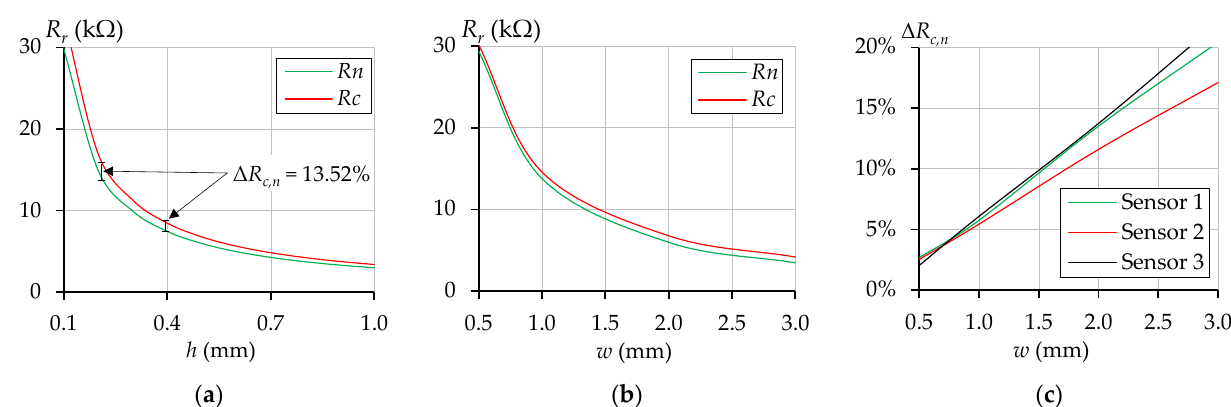
Figure 8. Numerically and analytically calculated: ( a ) the reference resistance of Sensor 1 for different thicknesses of the path at d = 20 mm and w = 2 mm, ( b ) the reference resistance of Sensor 1 for different widths of the path at d = 20 mm and h = 0.5 mm and ( c ) relative differences between numerical and analytical results for three sensors.